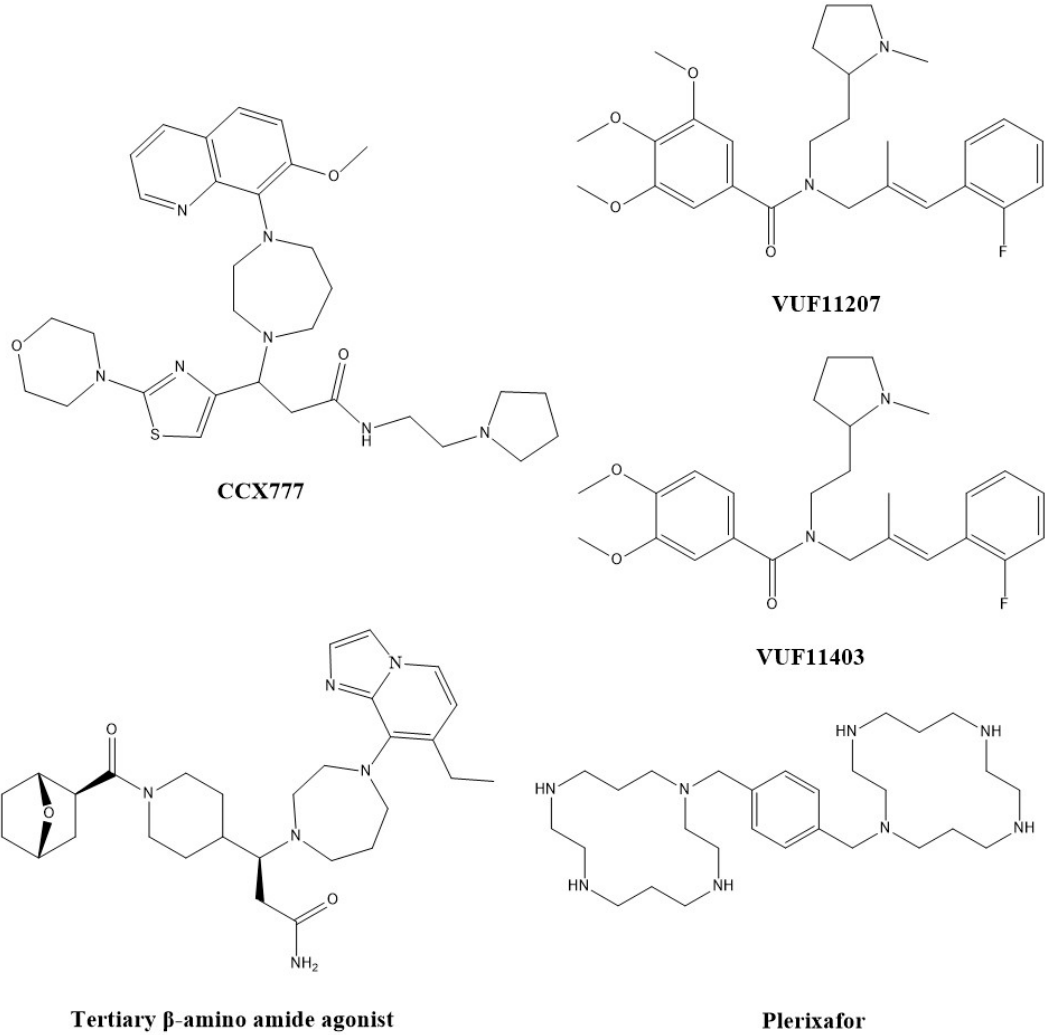
Figure 2. Small molecule modulators of